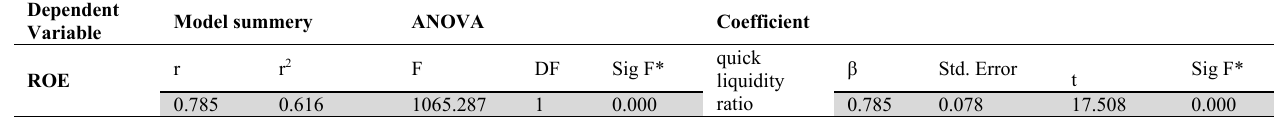
Simple regression test results, the effect of quick liquidity ratios at return on equity Dependent Variable